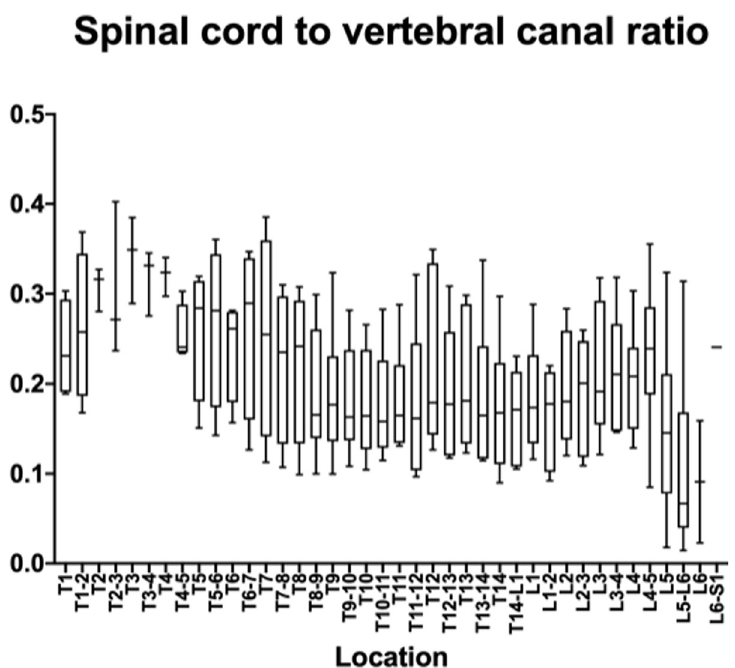
Fig 10. Graph of the spinal cord to vertebral canal ratio in 6 Yucatan sows. The median, 75 th , 25 th percentile and the range are shown for each thoracolumbar vertebral segment.